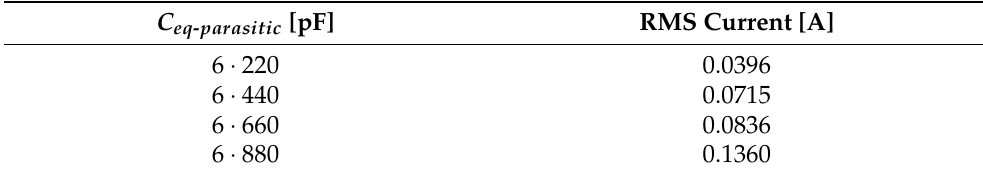
Figure 20. Bode Diagram of i cm ( s ) / v cmZC ( s ) with different values of C series and L cm = 3 × 2mH. Table 4. RMS values of i cm with L cm = 3 ×